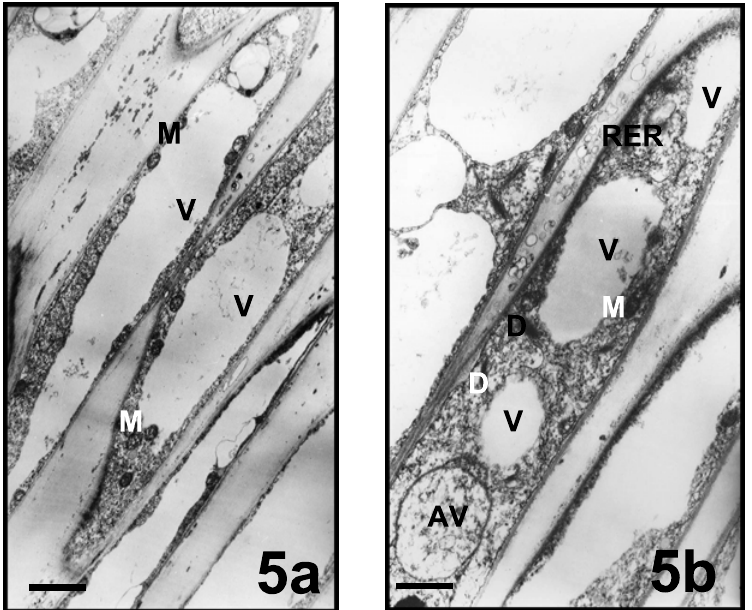
Fig. 5 – Vacuolation and plug formation zones of pollen tubes in Mimulus aurantiacus . a,b bar = 1 , 5 μ m; (AV, autophagic vacuole; D, dictyosome; M, mitochondria; RER, rough endoplasmic reticulum; V,